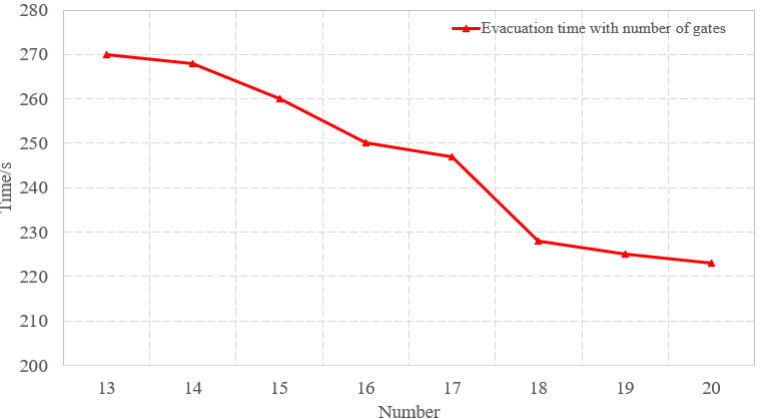
Figure 20. Trend of evacuation time with the number of gates. (2) Emergency evacuation with different widths of escalator The width of the escalator also has a certain impact on the evacuation time. The relationship between escalator width and evacuation time is shown in Figure